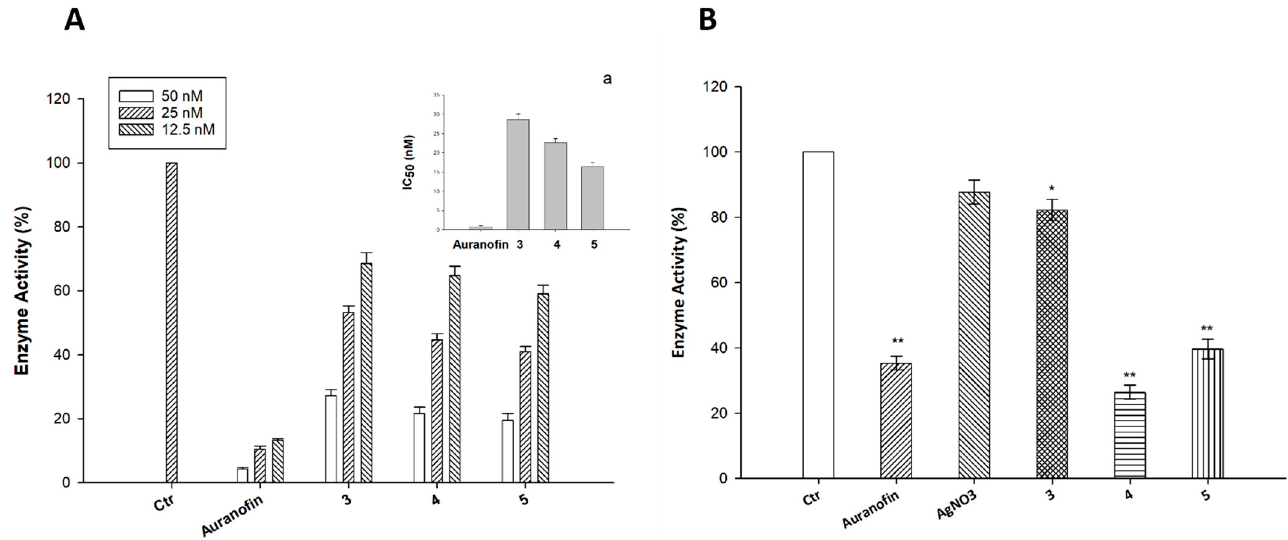
Figure 2. TrxR inhibition. ( A ) TrxR1 activity was assayed by measuring NADPH-dependent reduction of DTNB at 412 nm as described in the Experimental Section. (a) 50% inhibition concentration (IC 50 ), Error bars indicate S.D. ( B ) U1285 cells were incubated for 24 h with the tested compounds (2 µ M). Subsequently, cells were washed twice with PBS and lysed. TrxR activity was tested by measuring NADPH-dependent reduction of DTNB at 412 nm. Error bars indicate SD. * p < 0.05; ** p < 0.01.